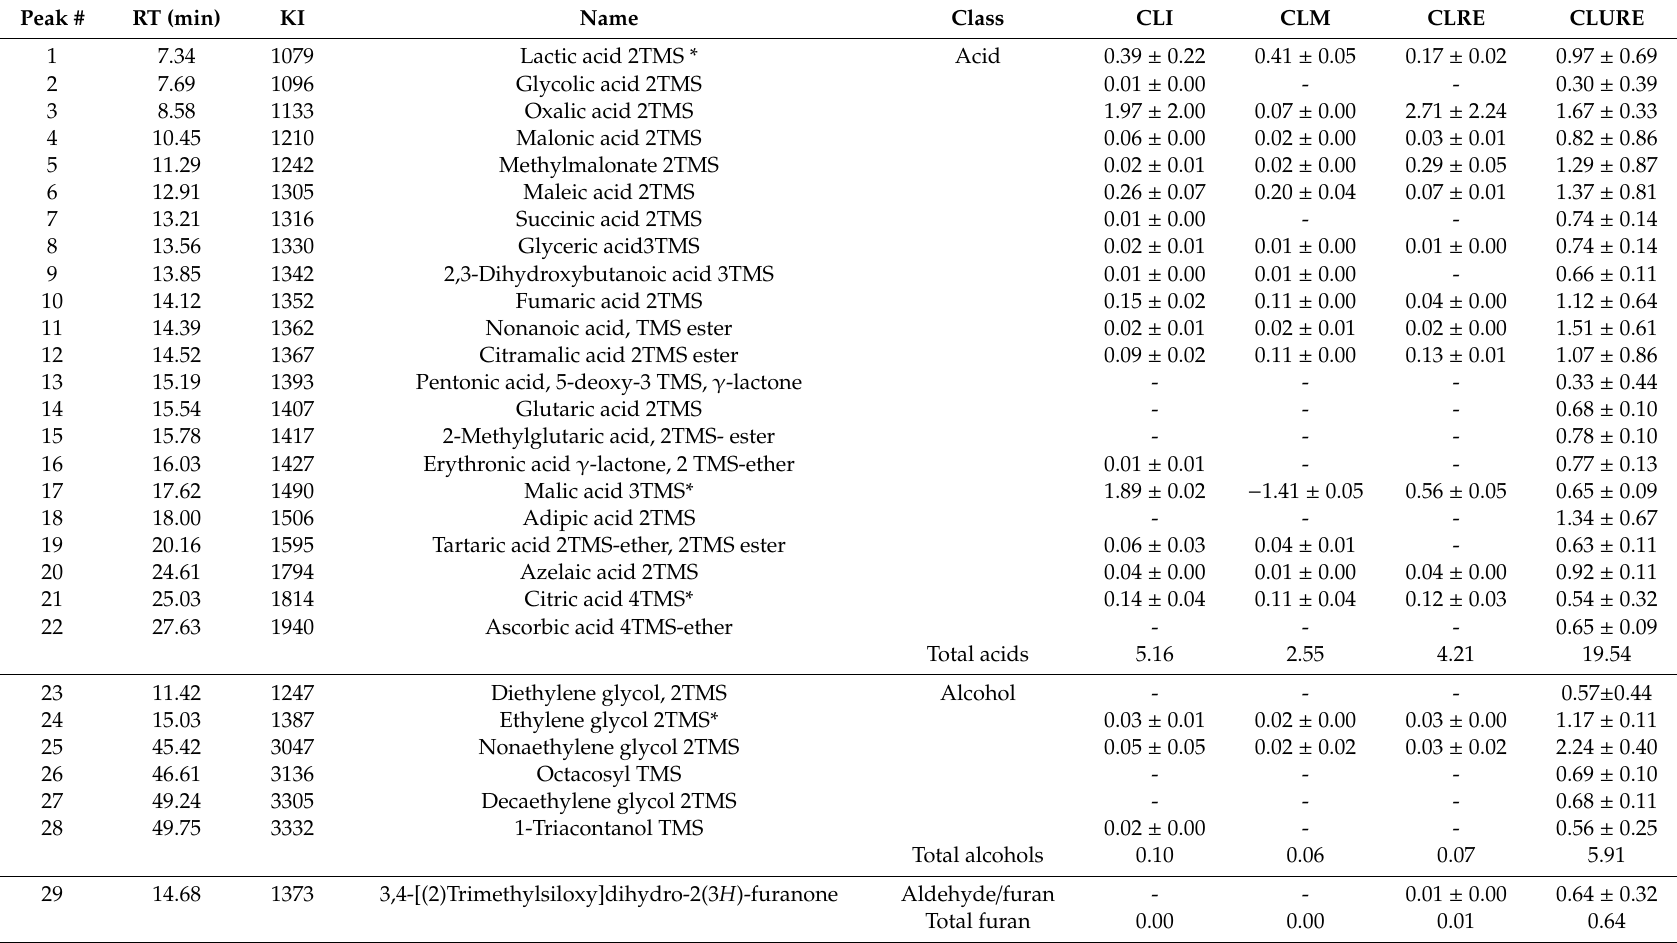
Table 1. Primary metabolites analysis using GC-MS from ripe and Egyptian unripe A. carambola fruits with results expressed as a relative percentile of the total peak areas ± std. deviation ( n = 3). (CLI) Indonesian ripe fruit, (CLM) Malaysian ripe fruit, (CLRE) Egyptian ripe fruit and (CLURE) Egyptian unripe fruit, n =